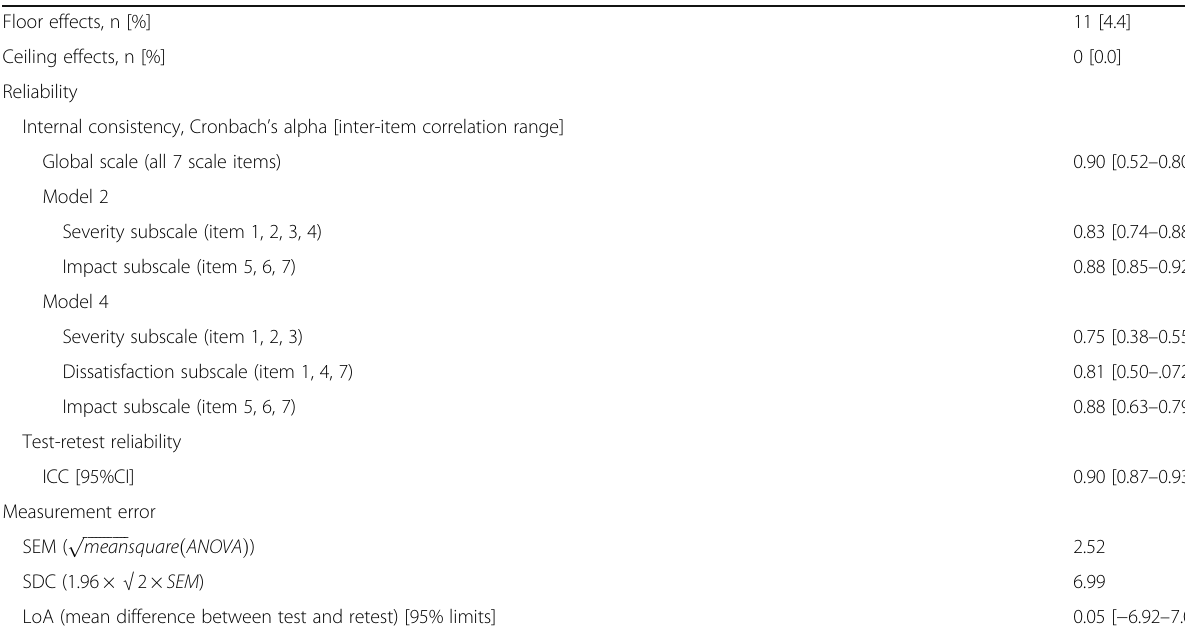
Table 4 Reliability, floor, ceiling effect, and measurement error of the Insomnia Severity Index Danish version ( n = 163)